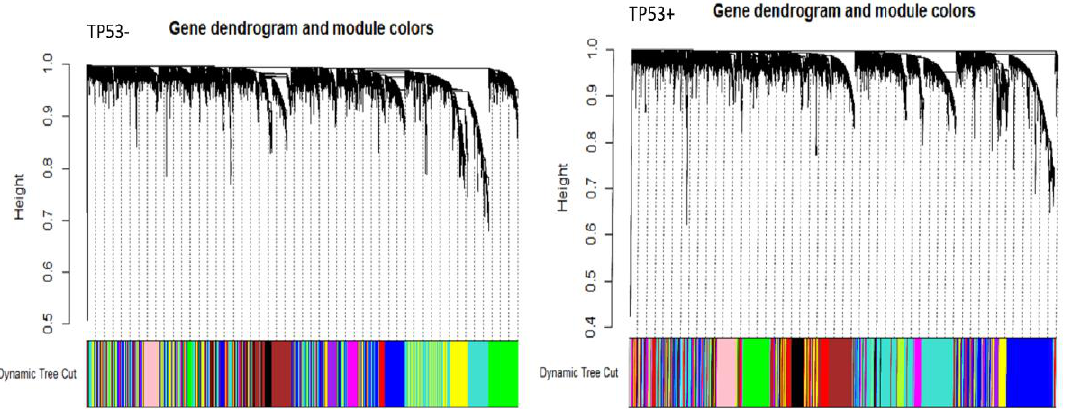
Fig. 2. Gene dendrogram of TP53 - and TP53 + gastric cancer subtypes: The hierarchical clustering tree was made using the dissimilarity measure based on Topology Overlap Matrix (dissTOM) of genes' expression values. The dynamic tree-cutting algorithm was used to create modules using the hierarchical clustering tree. This algorithm puts the genes with the lowest dissTOM in the same modules. 11 and 12 modules were identified for TP53 - and TP53 + respectively. Each color is assigned for each module as an identifier. The colored row below the dendrogram shows the merged